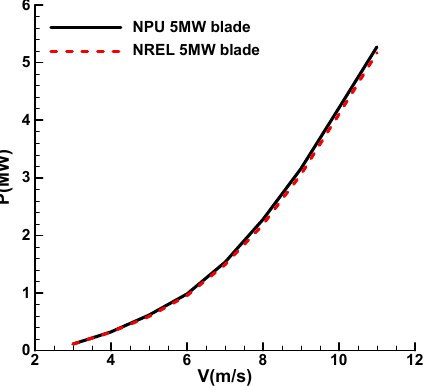
Figure 26. Comparison of power generation between the NREL 5 MW and NPU 5 MW by ROTNS.